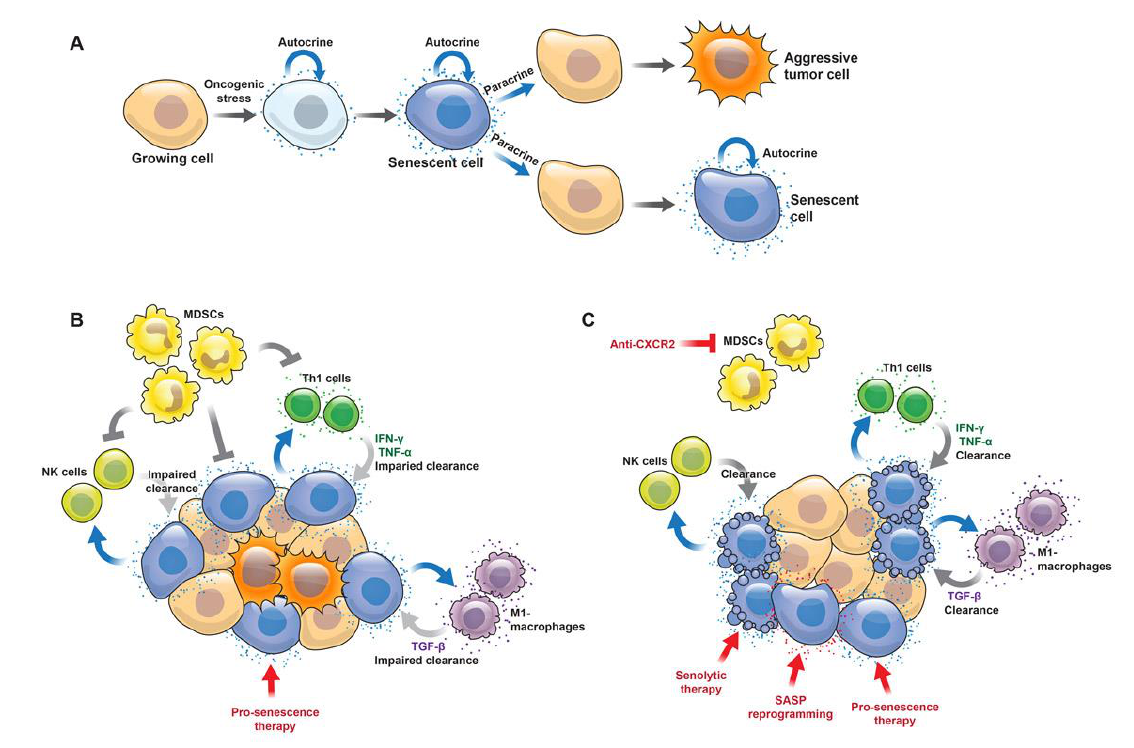
Figure 1: Combinatorial approach to enhance the efficacy of pro-senescent therapy. (A) Oncogenic stress drives growing cells into senescence. Senescent cells actively communicate with their microenvironment through the SASP. Depending on the composition of the SASP, secreted factors can either drive both autocrine and paracrine induction of senescence, or enhance the aggressiveness of neighbouring tumour cells. (B) Senescence induction in tumours treated with pro-senes- cence therapy. Within the tumour microenvironment, senescent tumour cells through the SASP can promote both the re- cruitment and activation of several immune populations, including M1-macrophages, NK cells, and Th1 cells. Such tumour- infiltrating immune subsets can restrain tumour progression by mediating the clearance of senescent tumour cells, and also promoting senescence. Conversely, MDSCs limit senescence induction in the tumour microenvironment by blocking senes- cence induction and/or anti-tumour immunity. (C) Optimisation of pro-senescence therapies for cancer. Immunotherapies may enhance tumour clearance in tumours treated with pro-senescence therapies. Pharmacological reprogramming of the SASP may increase the anti-tumour immune response in tumours upon treatment with pro-senescence therapies. Senolytic therapies may remove senescence tumour cells in tumours where senescence surveillance is impaired, to avoid negative effects induced by the SASP. Anti-CXCR2 treatment limits MDSC recruitment in the tumour, favouring senescence induction and/or antitumour immunity. From [1]. Ochre cells represent growing cells; light-blue cells show cells undergoing to senescence; blue cells represent senescent cells; orange cells depict aggressive tumour